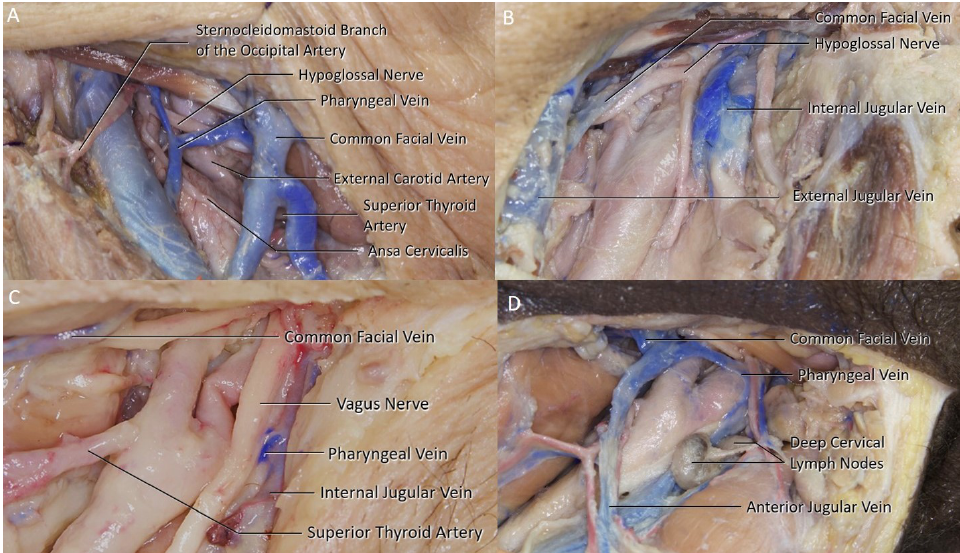
Figure 3. ( A ) Left side pharyngeal vein can be seen draining into the IJV separately from the common facial vein. ( B ) No ligation was required on the common facial vein as it drained into the external jugular vein. ( C ) Left side pharyngeal vein can be visualized as the only branch of the IJV at the surgical site. ( D ) Left side anterior jugular vein drains the common facial vein, in addition, a communicating vein between the common facial and pharyngeal vein can be seen.